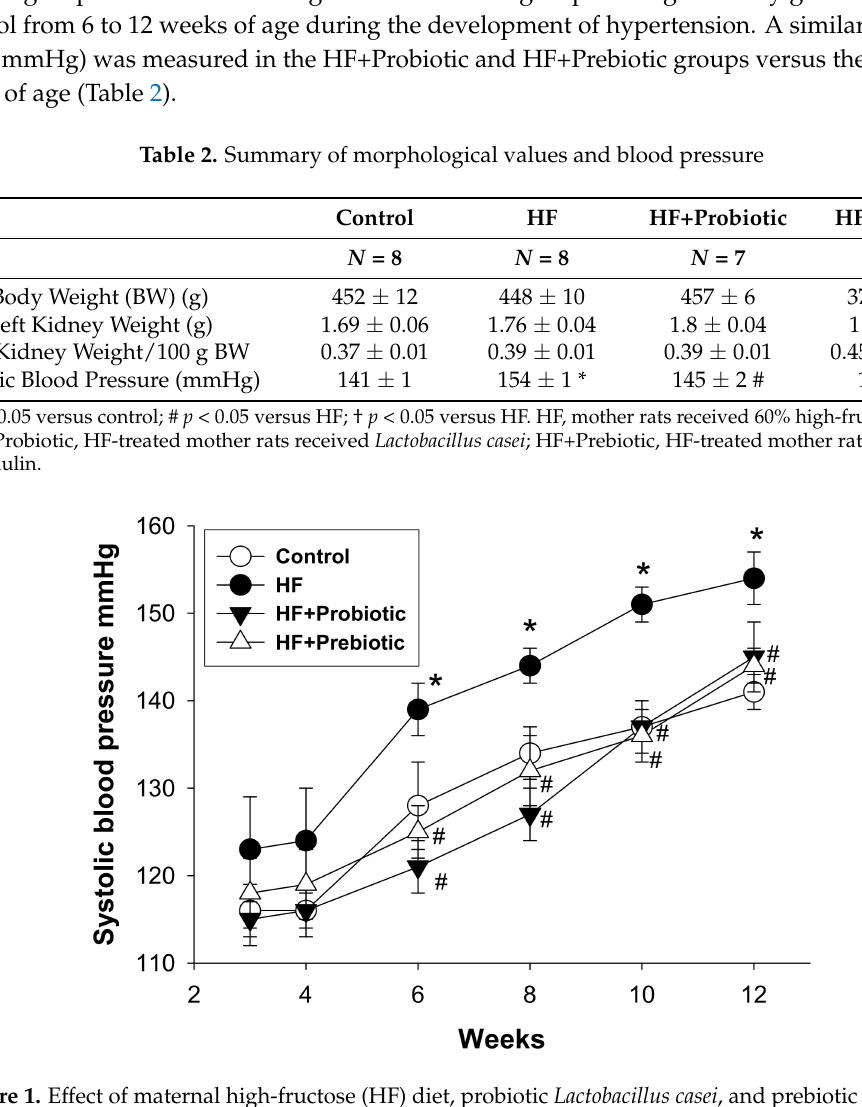
Figure 1. Effect of maternal high-fructose (HF) diet, probiotic Lactobacillus casei , and prebiotic inulin on systolic blood pressure in male offspring from 3 to 12 weeks of age. N = 7–8/group. * p < 0.05 versus control; # p < 0.05 versus